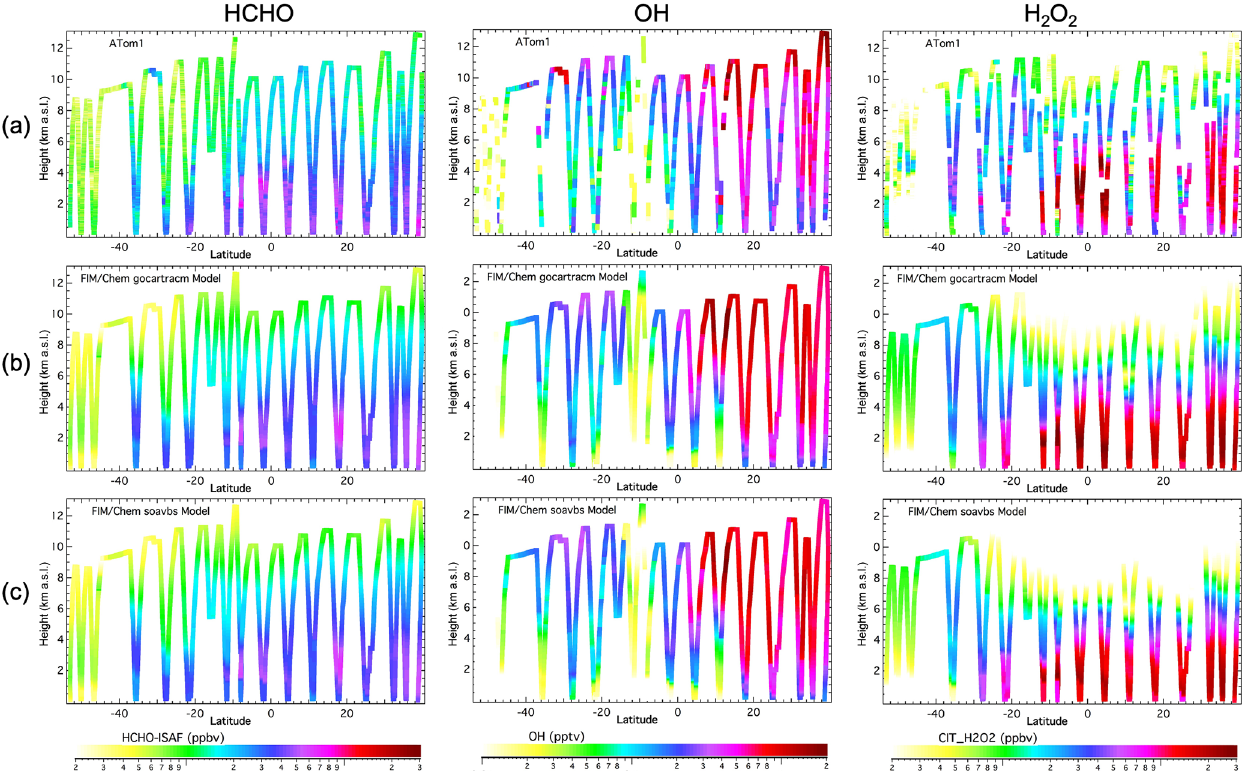
Figure 7. Height–latitude profiles of HCHO, OH, and H 2 O 2 over the Atlantic on 15 and 17 August 2016 for (a) ATom-1 observations; (b) RACM_GOCART; and (c)